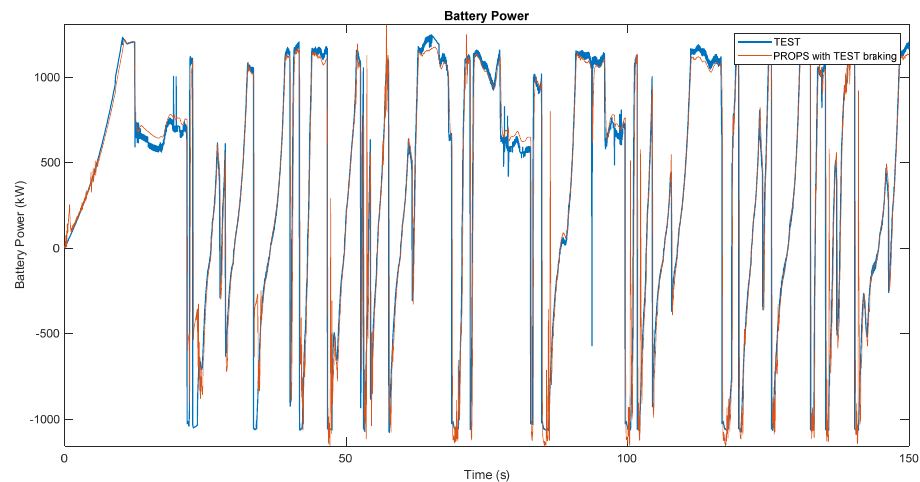
Figure 23. TEST (in blue) and PROPS (in red) battery power (in kW) vs. Lap Time (in seconds).